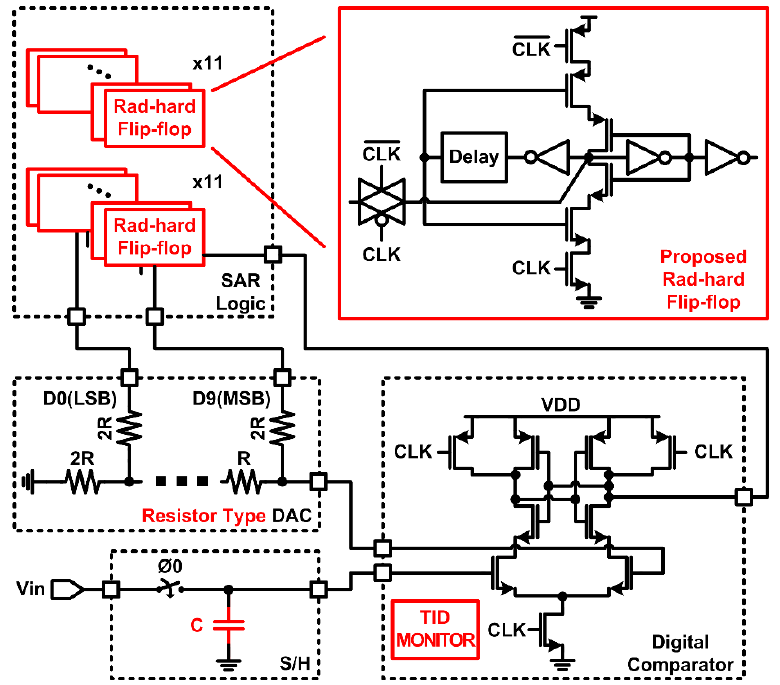
Figure 3. Block diagram of the resistor-type DAC (RDAC) -based successive-approximation- register (SAR) ADC with radiation-hardened flip-flops.